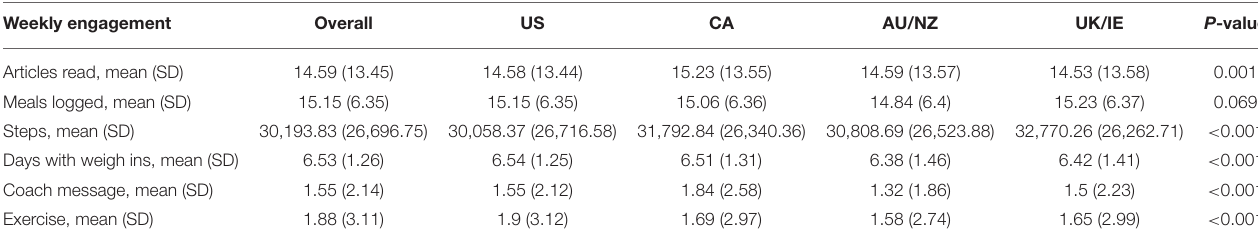
TABLE 4 | Average weekly engagement across